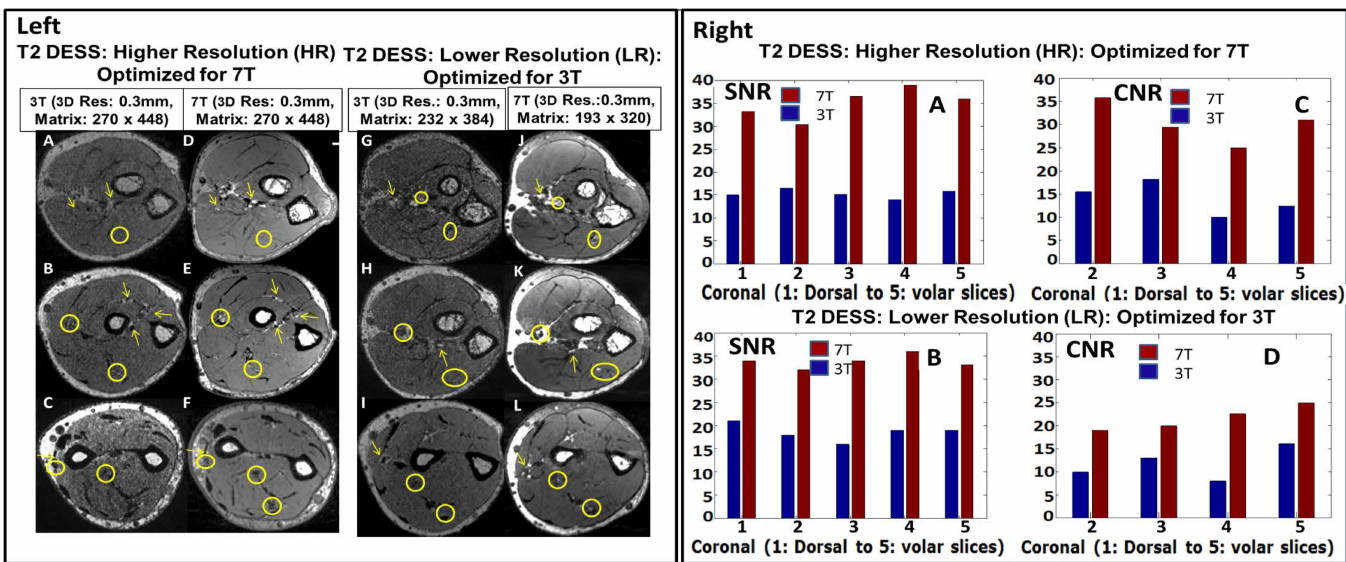
Fig 2. Left: 3T vs. 7T T2 DESS images on both higher[HR which is optimizedfor 7T] and lower [LR which is optimizedfor 3T] resolutions [as described Table 1]. Small order vessel [yellow arrows] and nerve [yellow circles] signalsas indicatedby circles are difficult to identify on the 3T [A, B, C, G, H and I] images but are well delineatedon the 7T [D, E, F, J, K, L] images Right: SNR and CNR charts for T1 VIBE images. [A and B] and [C and D] represent SNR and CNR; respectively. The 7T SNR and CNR were ~ 2/1.5 times that of 3T for the HR/LR scans, respectively.Out of all three volunteer, the abovedata is from single